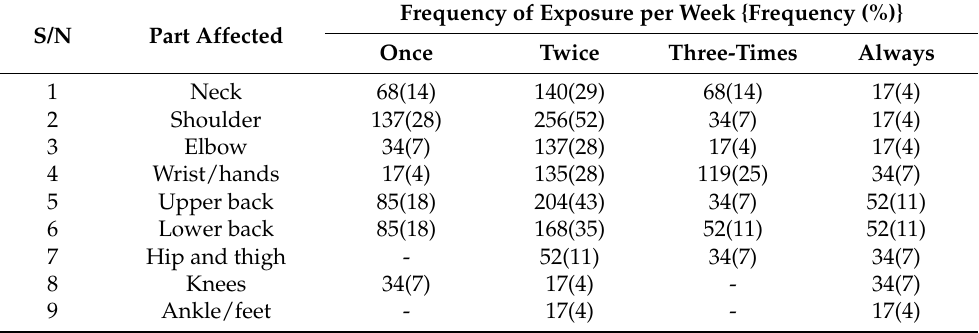
Table 3. Frequency of ergonomic hazards experienced by farmers/week (N = 480).